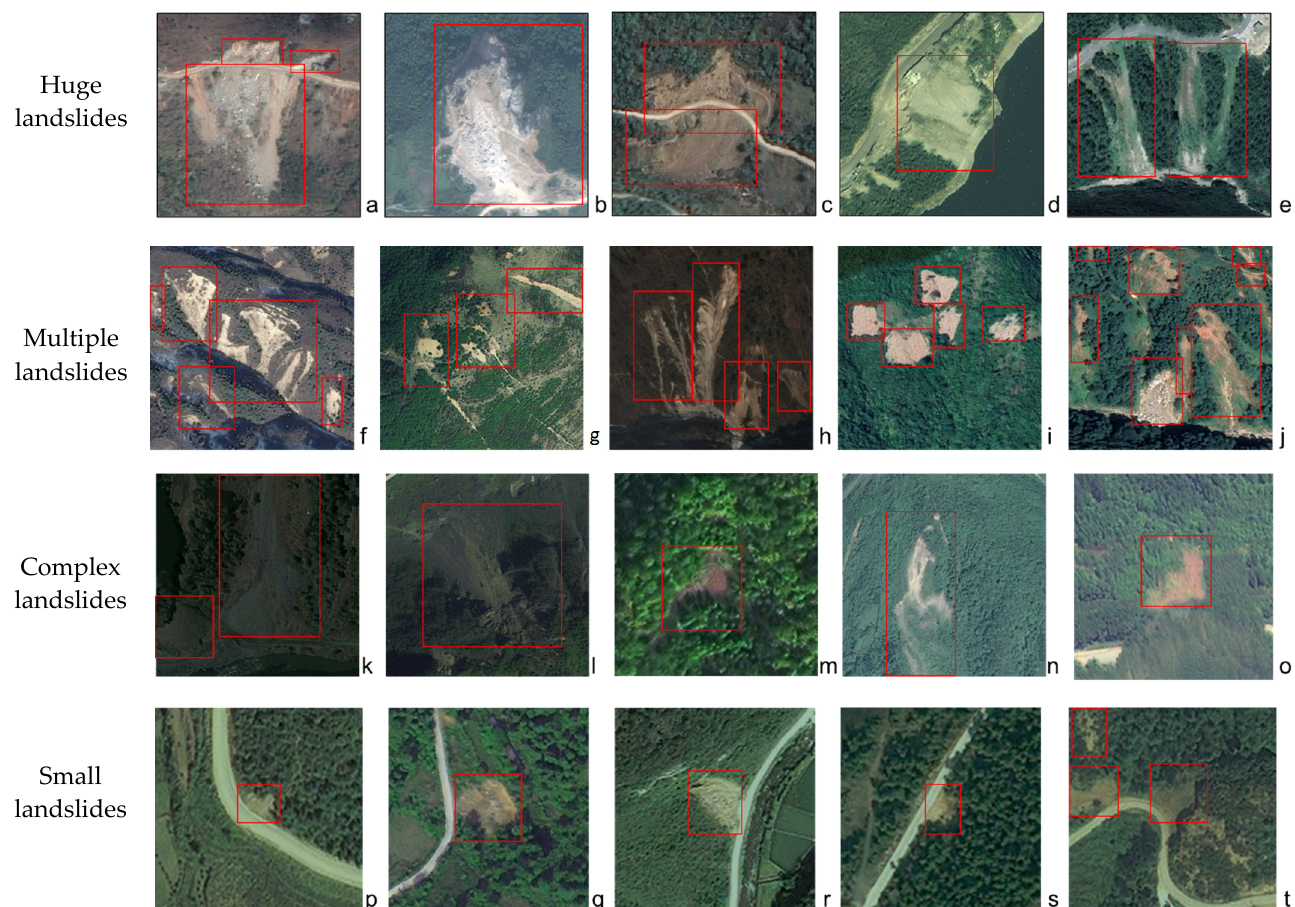
Figure 13. Detection results of potential landslide areas by YOLOX-Pro(M). The partially representative detection results of YOLOX-Pro for potential landslide areas. The red rectangles mark the boundaries of the landslide, which the model automatically detects. (Huge landslides) ( a – e ): the huge landslides. (Multiple landslides) ( f – j ): the multiple landslides of different sizes; (Complex landslides) ( k – l ): the historical landslides areas are very similar to the surrounding environment; ( m – o ): the landslides that have been covered by surface vegetation in some areas. (Small landslides) ( p – t ): the small landslides along the road.